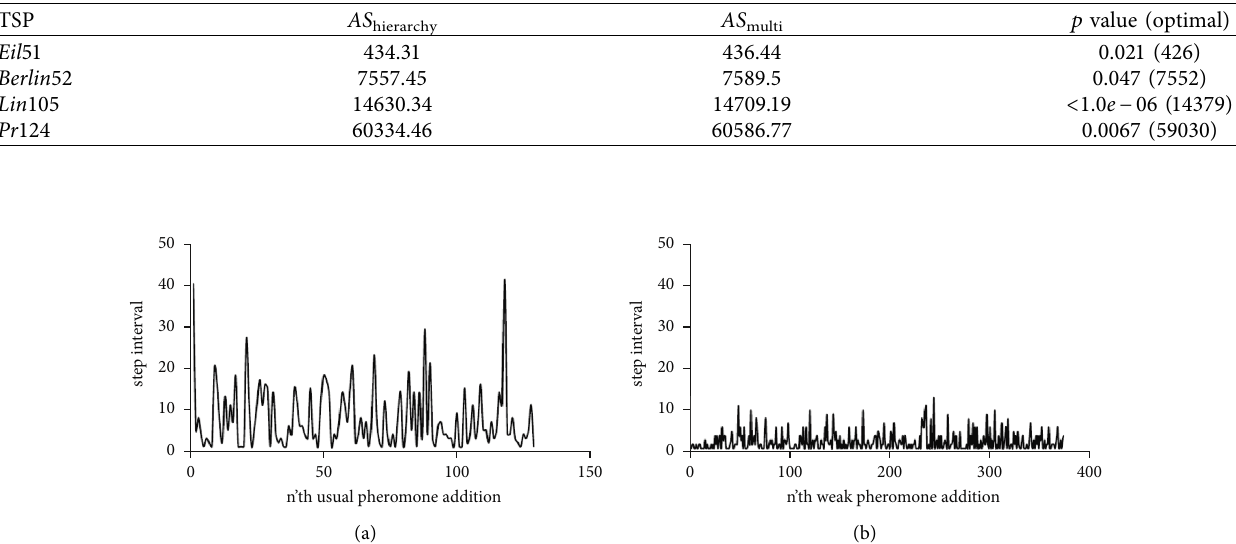
Table 2: Mean best solutions.